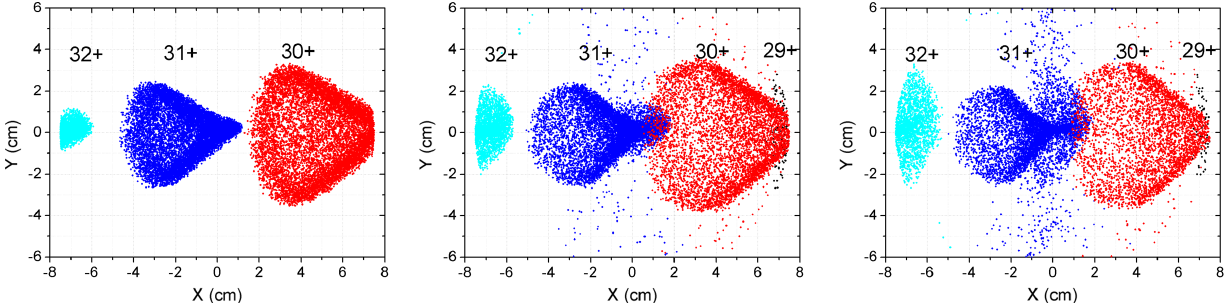
FIG. 14. Simulated particle distributions at the end of CSS under space charge compensation degrees of 70% (left), 50% (middle) and 30% (right).